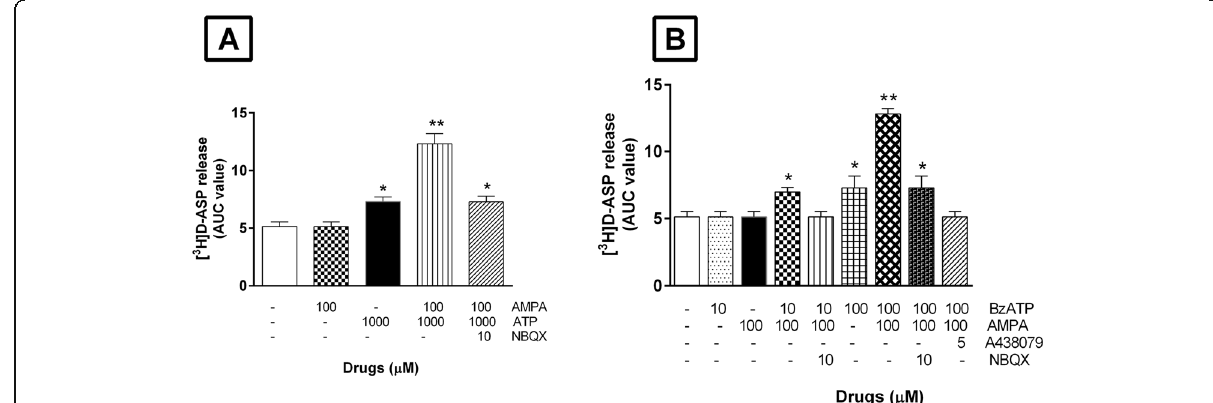
Fig. 3 Effects of AMPA and ATP (or BzATP) alone or in combination on basal [ 3 H]D-ASP release: a Effects of AMPA and ATP alone or in combination on basal [ 3 H]D-ASP release and their antagonism by NBQX. After 38 min of perfusion with standard medium, synaptosomes were exposed for 4 min to standard medium containing AMPA (100 μ M), ATP (1 mM), or both drugs together. When used, the antagonist NBQX (10 μ M) was added to the medium 8 min before the agonists. All results are expressed as areas under the release/time curves (AUCs). Each bar represents the mean ± SEM of 3 different experiments, each run in triplicate. *P < 0.05 vs basal release. **P < 0.01 vs basal release. b Effects of BzATP and AMPA alone or in combination and their antagonism by A438079 and by NBQX. The effects of BzATP were tested at two concentrations (10 and 100 μ M), each in the presence or absence of AMPA (100 μ M). Exposure times to agonists and antagonists (A438079 and NBQX) are those described in panel A. Each bar represents the mean ± SEM of 3 different experiments, each run in triplicate. *P < 0.05 vs basal release. **P < 0.01 vs basal